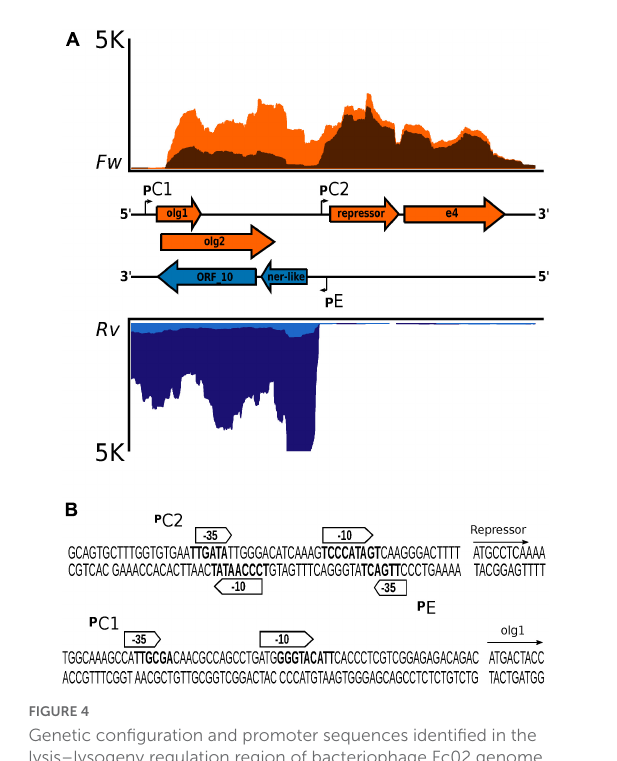
FIGURE4 Genetic configuration and promoter sequences identified in the lysis–lysogeny regulation region of bacteriophage Fc02 genome. (A) Blow up of the strand-specific RNA-Seq reads mapping in the regulation region (lysogeny-lysis switch) in Figure 3 . Graphs in orange represent the reads coverage mapped to the forward strand ( Fw ) at 5 min (light orange) and 10 min after induction at 40 ◦ C (dark orange). Graphs in blue, inverted relative to the orange plots, denote the reads coverage of the reverse strand ( Rv ) at 5 min (light blue) and 20 min (dark blue) after induction. In the middle, separating both graphs is presented in a map to the scale of the genes (colored arrows) and the location of the promoter sequences (angled arrows). The genes olg1 and olg2 are overlapped in the zero and +1 frames. The e4 arrow is a putative accessory gene of unknown function. In both coverage graphs, the upper limit was ± 5 K reads (vertical axis). The horizontal axis represents the 1,980-nucleotide length of the regulation region. (B) Sequence detail of the putative promoters identified using BProm, SAPPHIRE, and Promoter